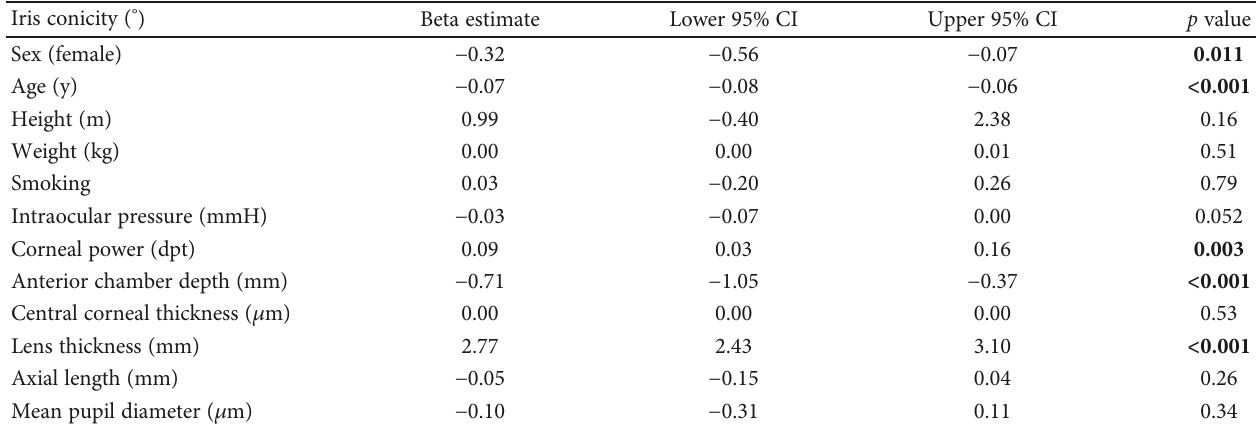
Table 3: Associations of iris conicity and anthropometric and ocular characteristics including ocular geometric parameters in the Gutenberg Health Study. We used a generalized estimating equation model to consider correlations between right and left eyes in our statistical model. CI: con fi dence interval.